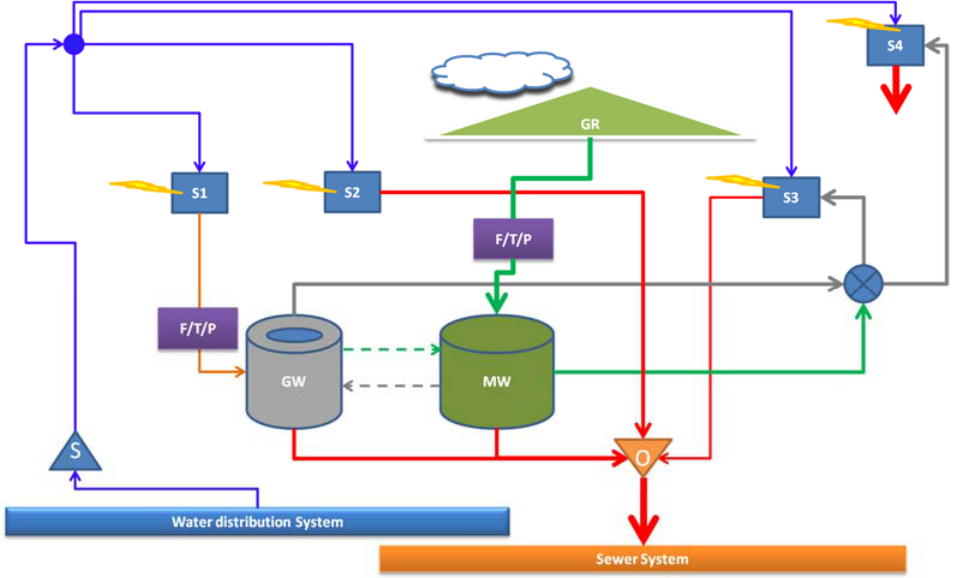
Figure 6. Schematic representing a building in theGSTMM model.